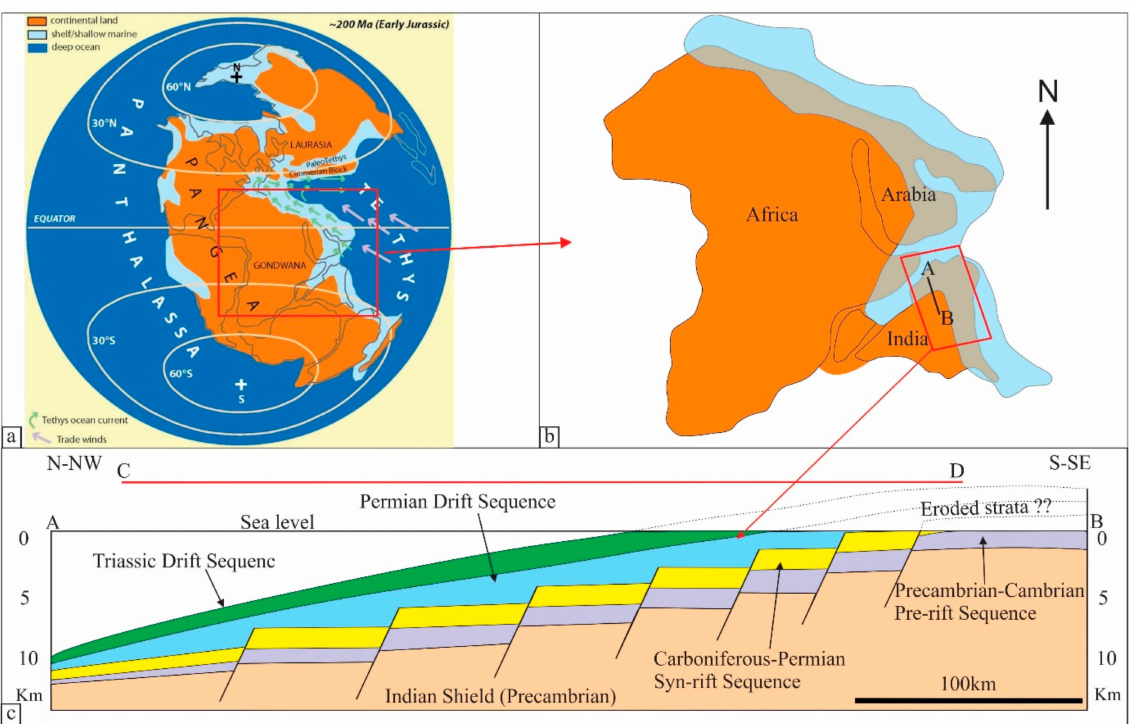
Figure 16. ( a , b ) Palaeogeographic position of the Salt and Trans–Indus ranges during the TJB interval with location of cross section A–B [90]; and ( c ) tentative basin cross-section A–B of the northwestern passive margin of the Indian Plate during Late Triassic (modified from [42]) with pre-rift, syn-rift, and drift sequences marked e.g., [16]. Location of cross section C–D (explained in Figure 17) is also